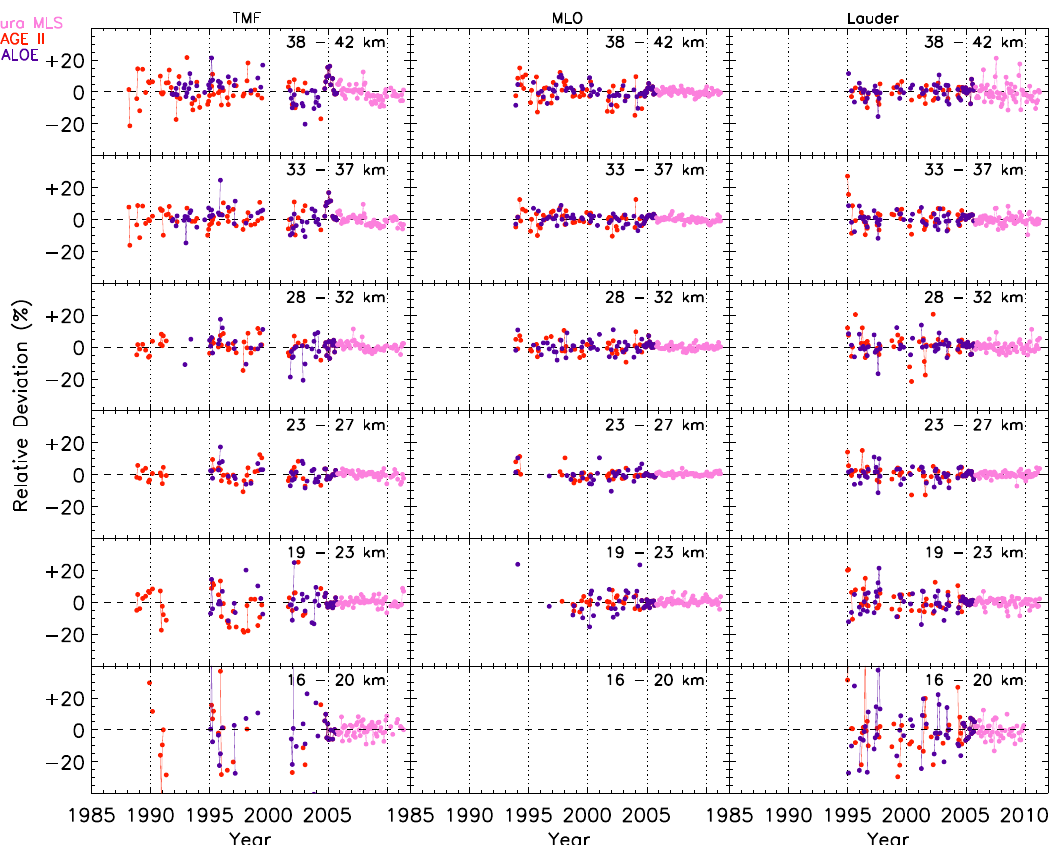
Fig. 9. Same as Fig. 8, but at TMF (left panel), MLO (middle panel) and Lauder (right